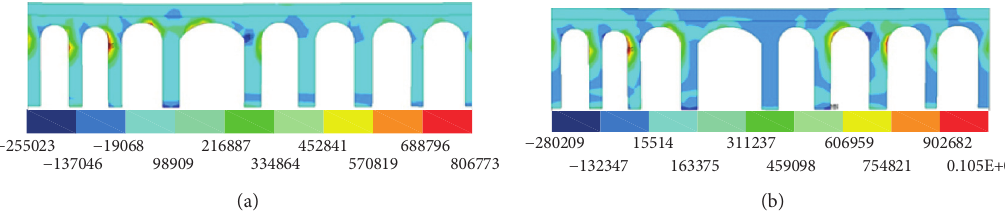
Figure 10: First principal stress of aqueduct structure. (a) After the excavation of the left tunnel. (b) After the excavation of the right tunnel.